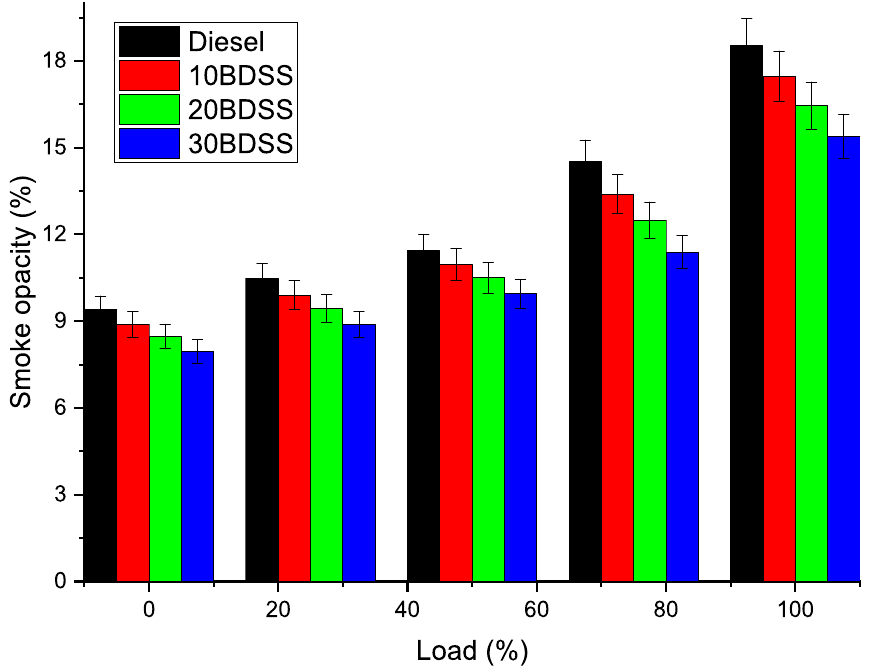
Figure 8. Influence of biodiesel blends in smoke